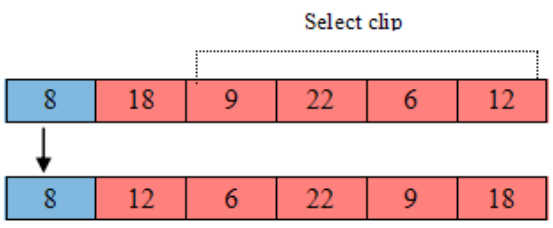
Figure 3. Second type of confluence update.